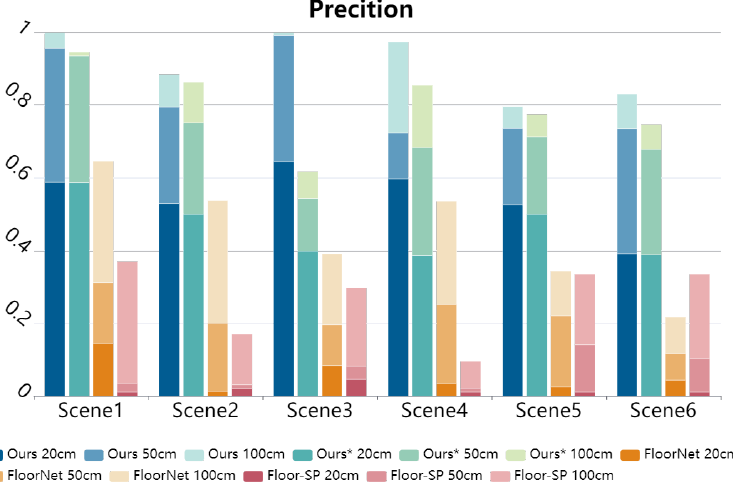
Figure 5. Quantitative comparison of our method with FloorNet and Floor-SP in terms of precision. The figures are represented by increasing numbers. Our* is the non-Manhattan result of our method.